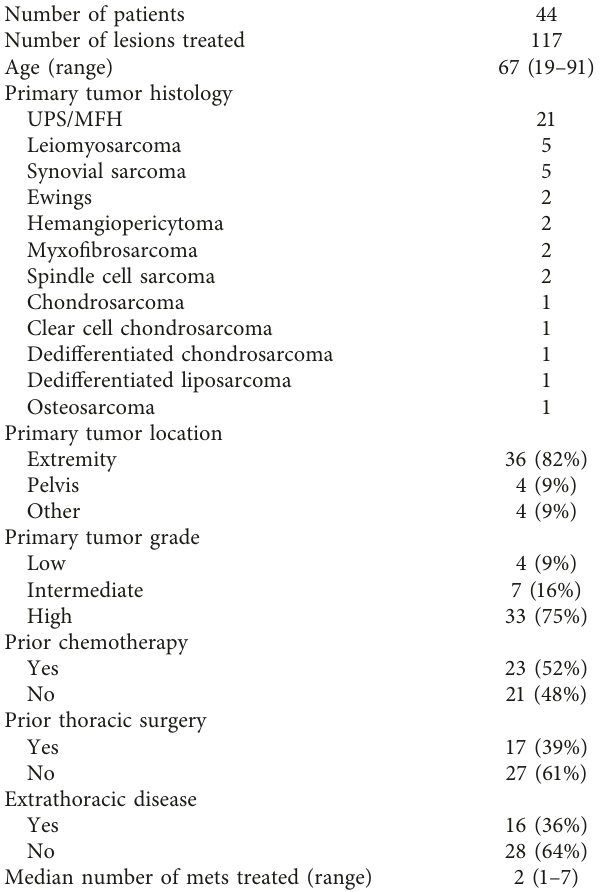
Table 1: Patient